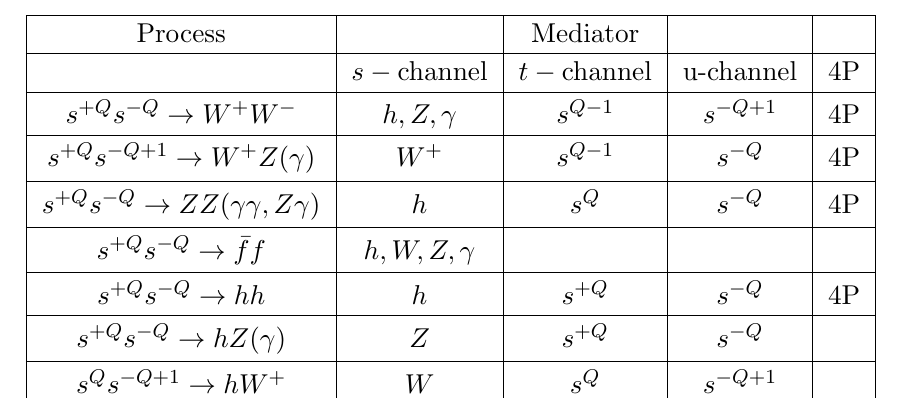
Figure 2 . Contours of the dark matter relic density ((cid:10) h 2 = 0 : 1186) in the M (cid:0) (cid:21) e(cid:11) plane. The solid line (red) corresponds to the co-annihilation case, the long-dashed line (blue) represents the one- species scenario. The short-dashed (black) line includes the Sommerfeld enhancement e(cid:11)ect (see section 3.3 below). The top (bottom) panel describes the septuplet (quintuplet) dark matter case.